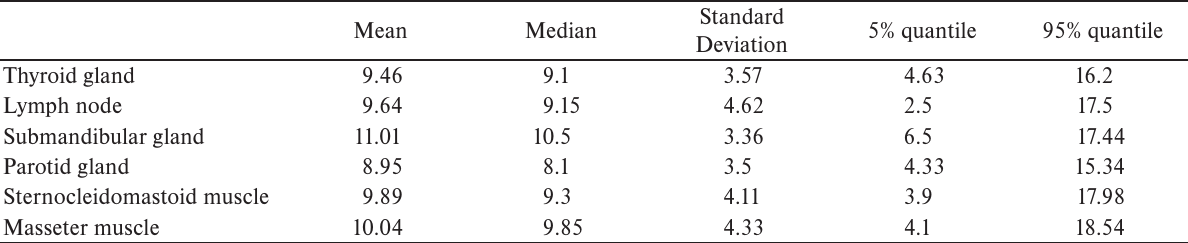
Table 2. Stiffness of the of head and neck tissues in